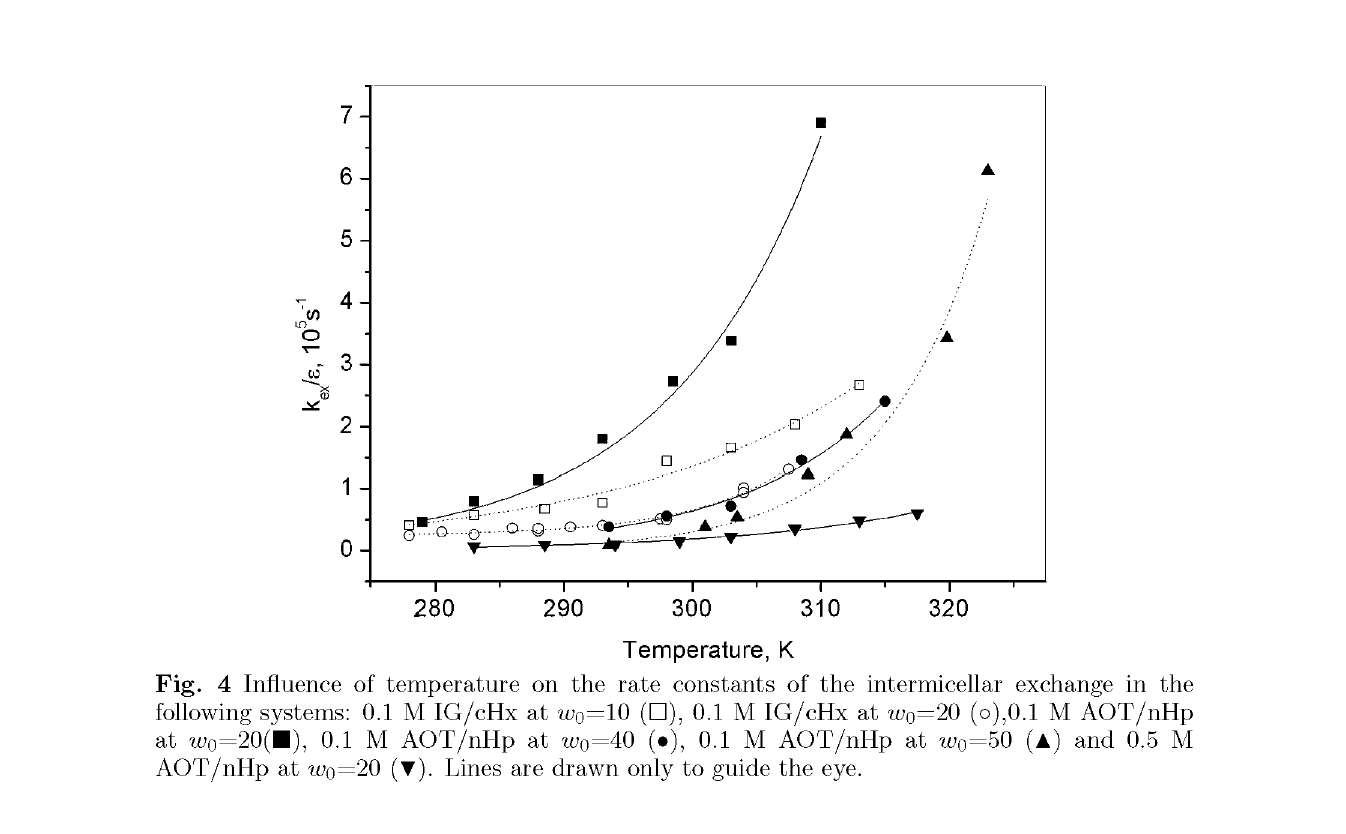
Fig. 4 Influence of temperature on the rate constants of the intermicellar exchange in the following systems: 0.1 M IG/cHx at w0 10 (D), 0.1 M IG/cHx at w0 20 (o),0.1 M AOT/nHp at w0 20(m), 0.1 M AOT/nHp at w0 40 (.), 0.1 M AOT/nHp at w0 50 (A) and 0.5 M AOT/nHp at w0 20 (v). Lines are drawn only to guide the